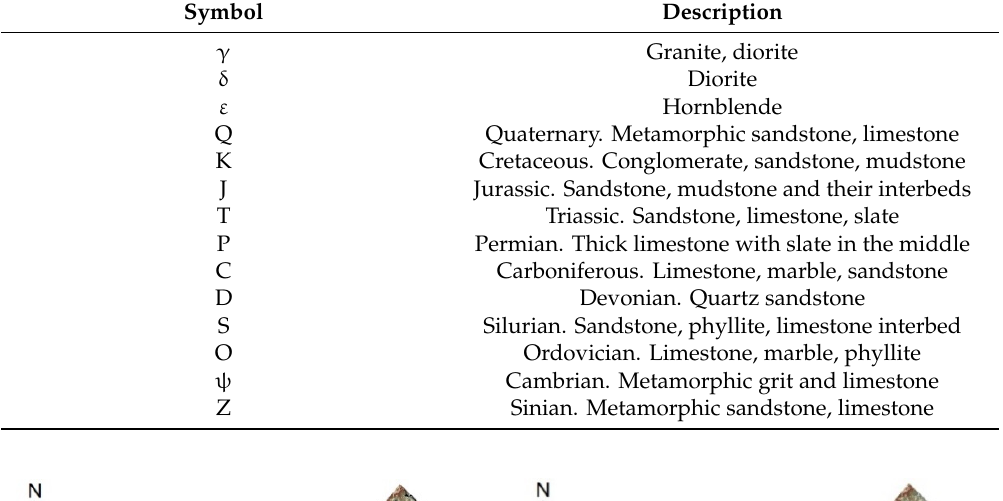
Table 2. The description of lithology in the study area.